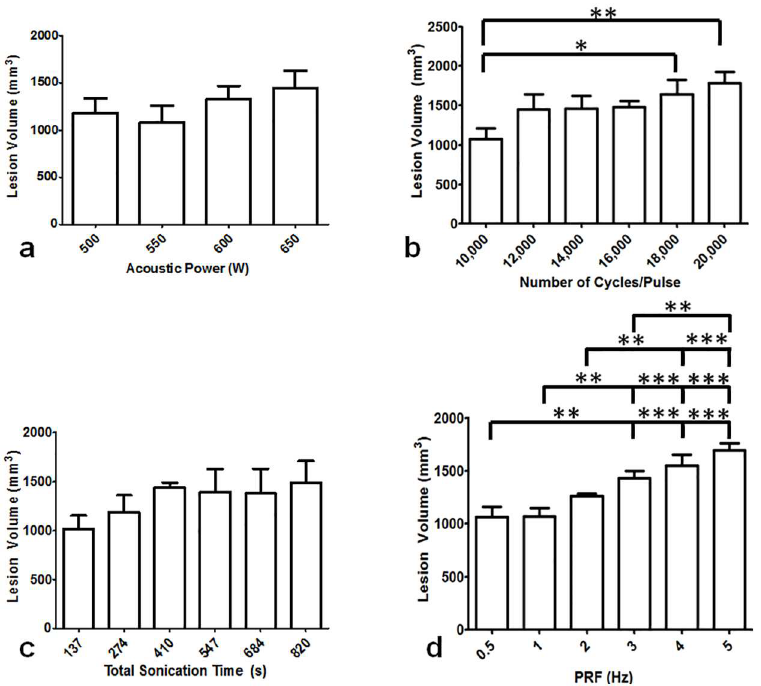
Fig 3. Lesion volume in tissue-mimicking phantom for varying BH sonication parameters. a . Lesion volume did not vary significantly for acoustic power 500–650W at constant PRF of 1 Hz (p > 0.05,ANOVA). b . Lesionvolume with varyingcycles/pulse. Significantdifferences (p (cid:20) 0.05) in lesion volumes were found between10,000 and 18,000 cycles/pulse as well as 10,000 and 20,000 cycles/pulse. c . Varying total sonicationtime between137 to 820 seconds resultedin no significantdifferences(p (cid:20) 0.05). d . Pulse repetitionfrequency (PRF) was varied from 0.5 to 5 Hz. The lesion volumeswere significantly different between0.5 and 3, 4, and 5 Hz (p (cid:20) 0.05). Similar differences were found between1 and 3, 4 and 5 Hz, as well as between2 and 4 and 5 Hz (p (cid:20)